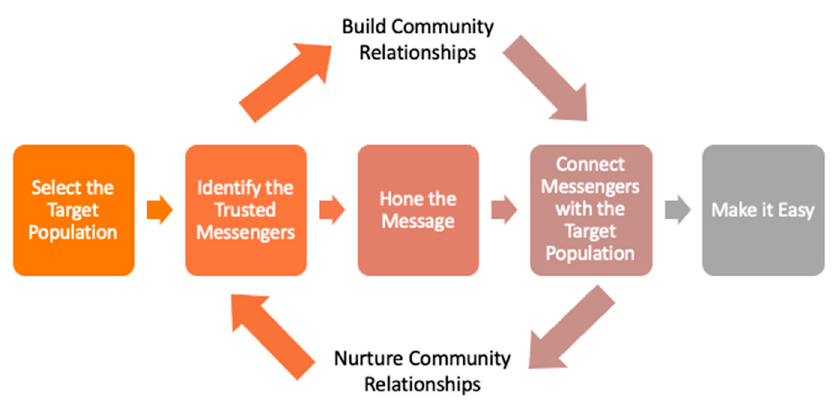
Figure 1. Sprint Vaccine Intervention Model.